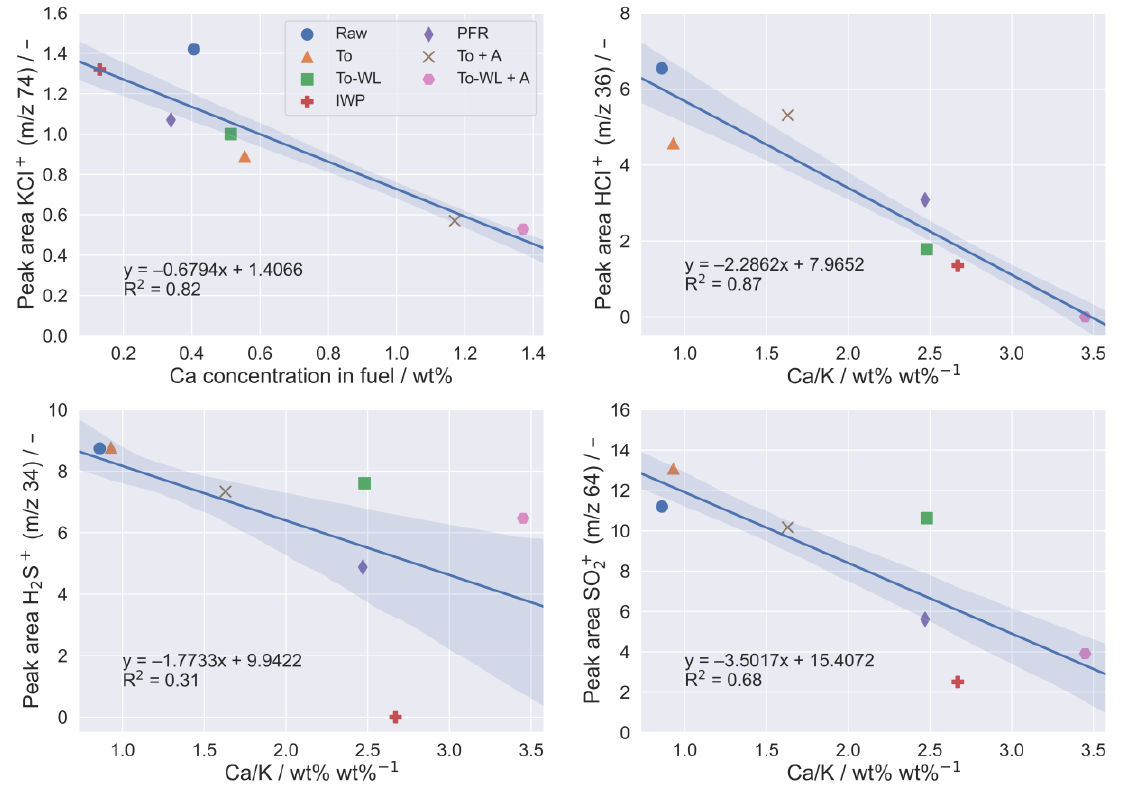
Figure 7. Correlation between the normalized volatile peak area (Figure 6) of KCl, HCl or sulfur- containing species and the concentration of Ca in the (pre-treated) fuel samples ( top-left ) or the weight ratio of Ca to K. The confidence interval is set at 68%.